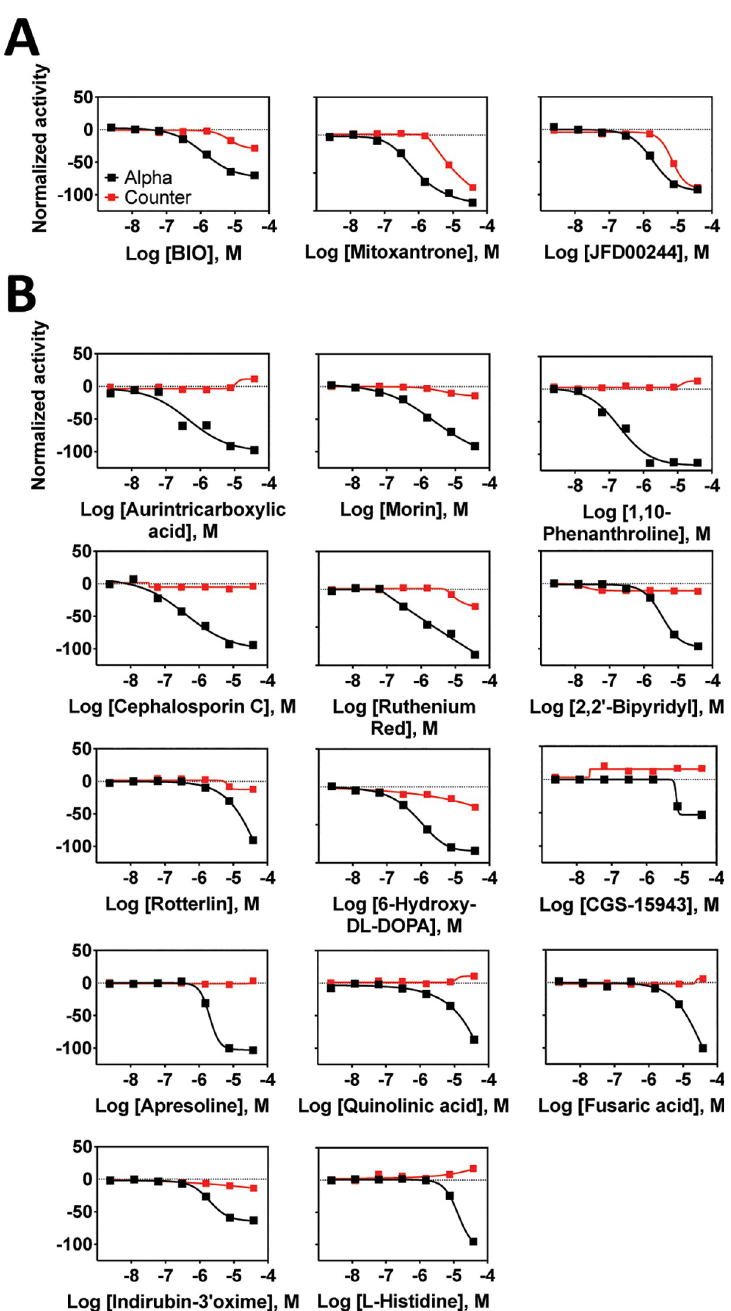
Fig 11. LOPAC active compounds from the AlphaScreen assay. Normalized activity signal for the specific AlphaScreen assay (Alpha) and the non-specific counter screen assay (counter) for each active compound reported for the 7-point concentration response generated using qHTS. Normalized activity in the AlphaScreen assay was calculated with neutral control (CD47 + SIRP α , no inhibitor) as 0% and negative control (CD47—SIRP α , no inhibitor) as -100% activity. Normalized activity in the counter screen assay was calculated with neutral control (+TruHits reagent, no inhibitor) as 0% and negative control (-TruHits reagent, no inhibitor) as -100% activity. Assay activity with tested compounds was then compared and normalized within this range. (A) Compounds that interfered with the assay as indicated by significant activity in the counter screen assay. (B) Reactive compounds identified as active in a variety of other unrelated screening